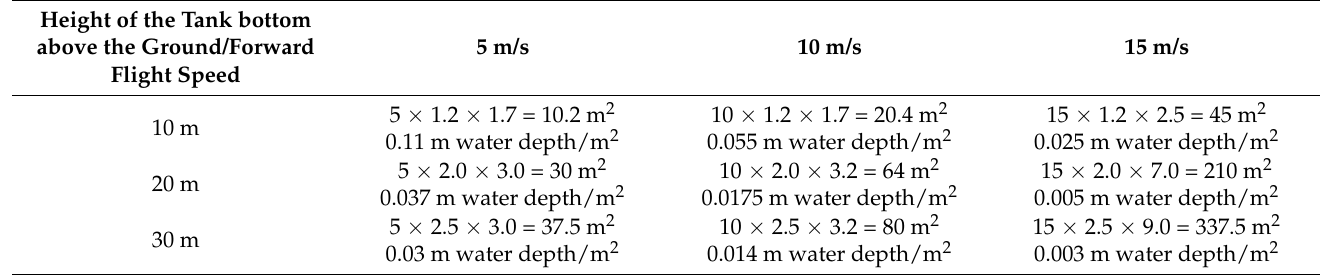
Table 2. Average water distribution on the ground with the helicopter flying forward when making a water dump (no